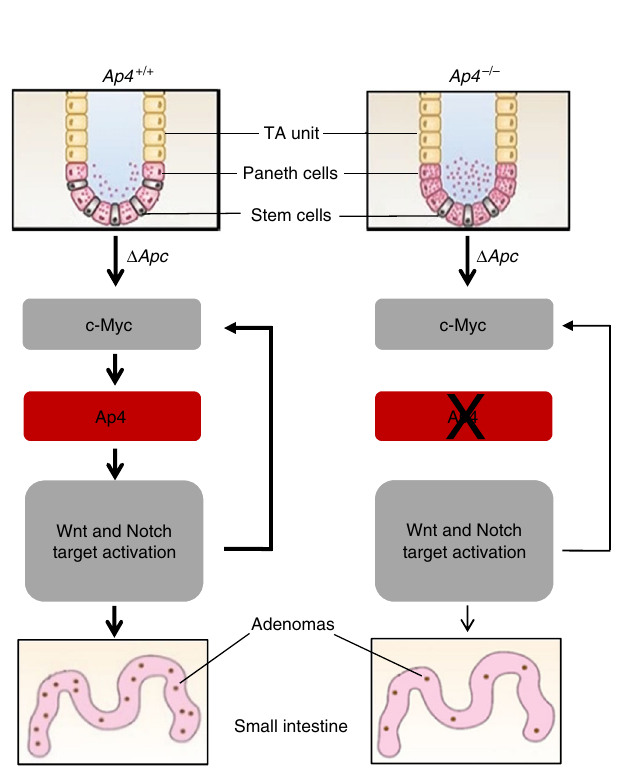
supernatant including IECs was centrifuged and the pellet was washed with ice- cold PBS, frozen in liquid nitrogen and stored at − 80°C until RNA isolation.